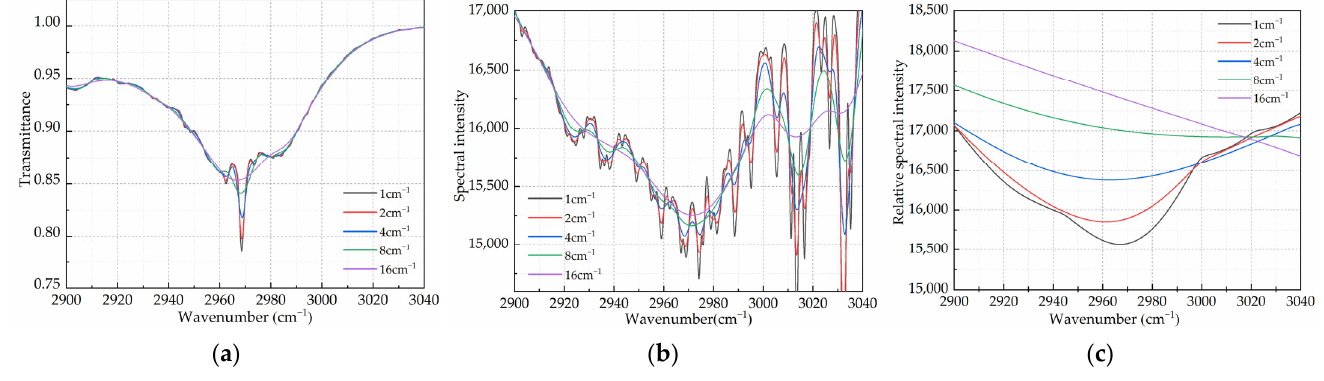
Figure 5. ( a ) The standard transmittance spectrum of C 3 H 8 with different resolutions; ( b ) the measured spectrum of C 3 H 8 with different resolutions; ( c ) the synthetic background spectrum of C 3 H 8 at different resolutions when the number of smoothening points is 9 and the number of filtering times is 100.